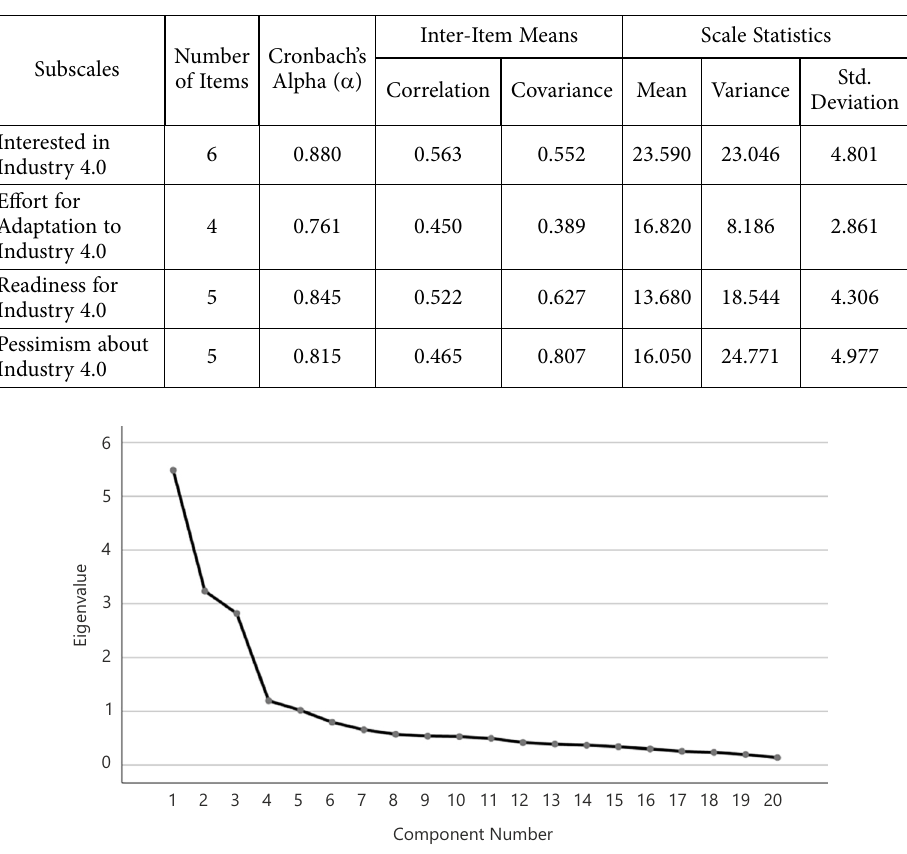
Table 7. Reliability analysis results